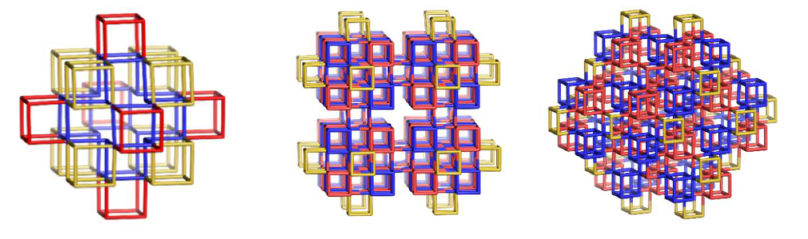
Figure 1: rh12.14 (rdo [4^12]—middle) and rh24.26 (mtp [4^24]—right). These shapes result by iterating